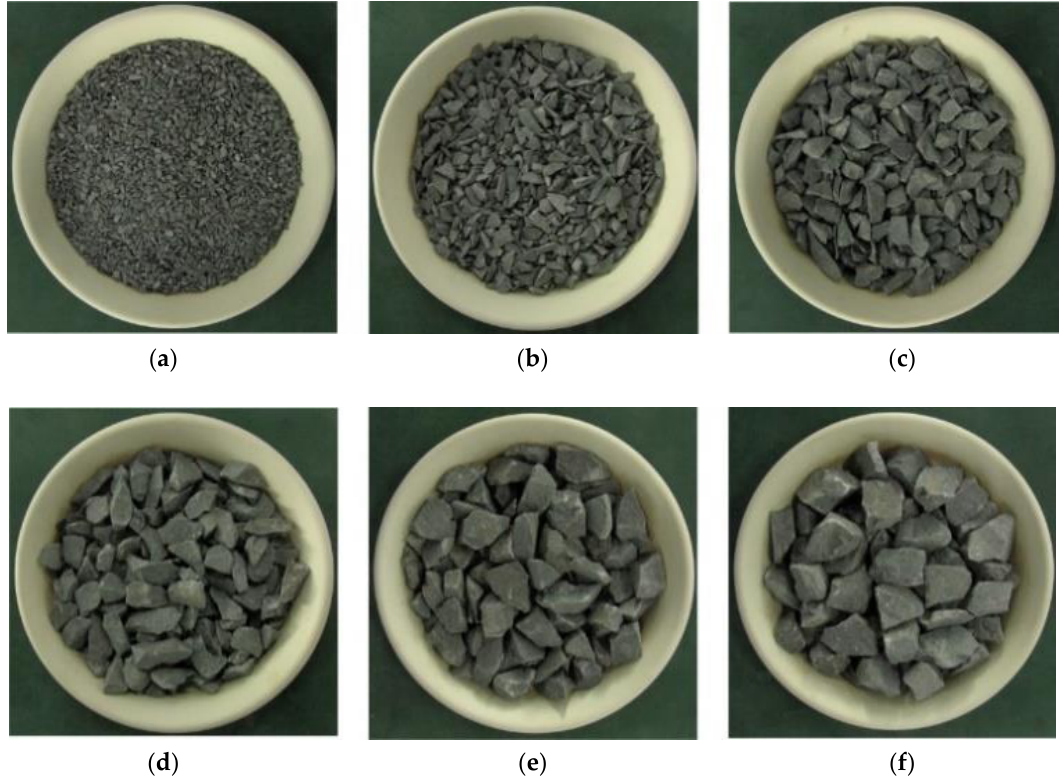
Figure 2. Samples of crushed sandstone with different particle sizes: ( a ) 0 – 5 mm, ( b ) 5 – 10 mm, ( c ) 10 –